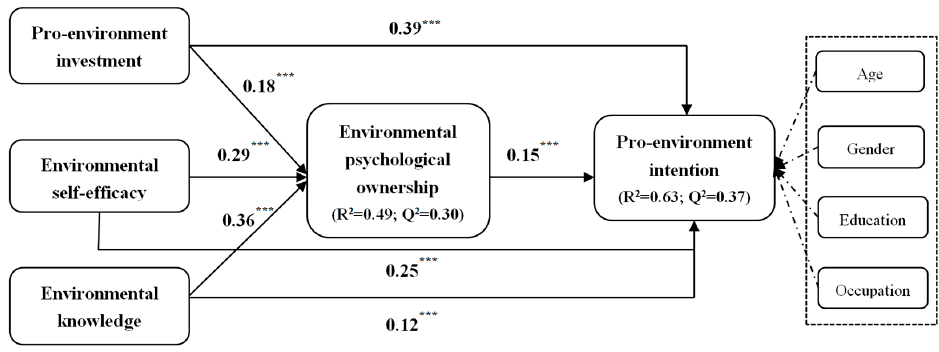
Figure 2. The estimates of SEM. Note: *** p < 0.001,